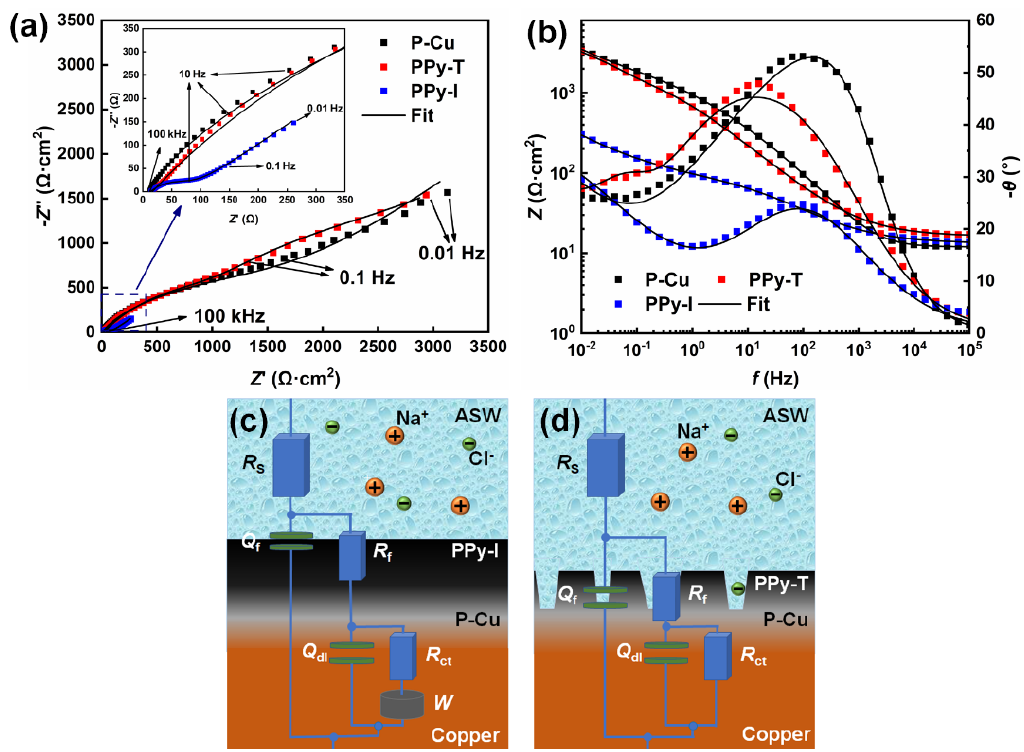
Figure 5. Nyquist ( a ) and Bode plots ( b ) for passivated copper and PPy-T- and PPy-I-coated copper specimens after 24 h immersion in ASW at 298 K along with the equivalent circuit ( c ) and ( d ). Table 3. Impedance parameters for passivated copper and PPy-T- and PPy-I-coated copper speci- mens after 24 h immersion in ASW at 298 K.